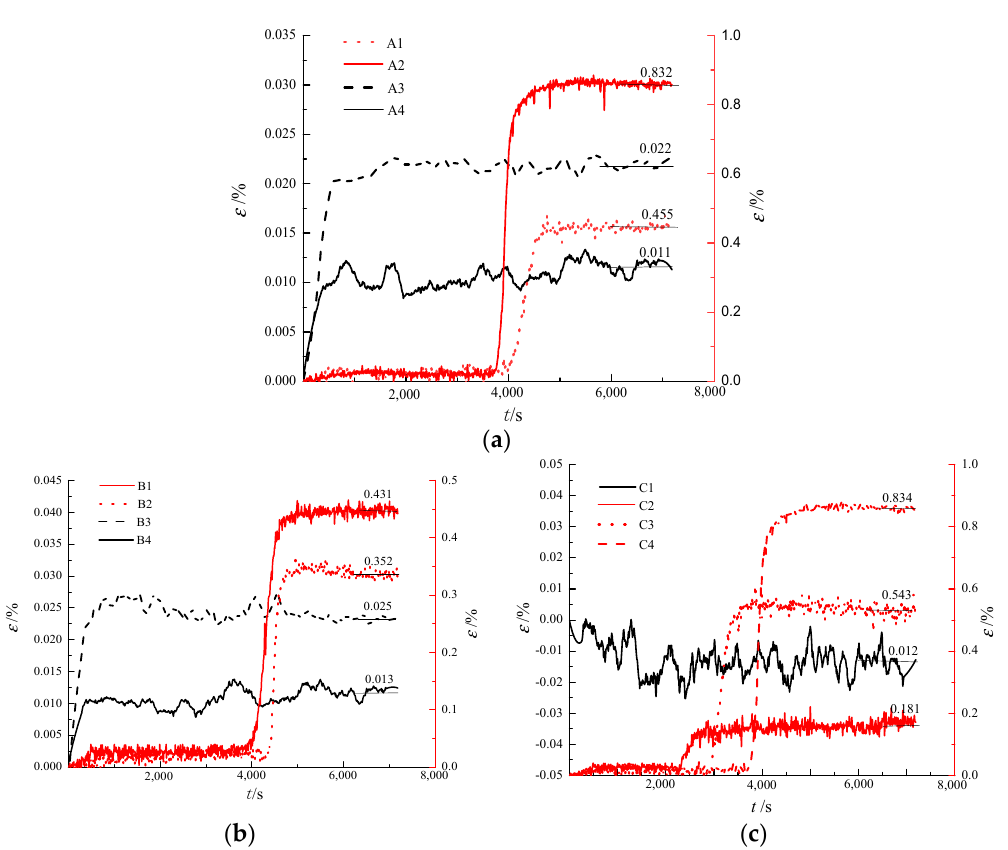
Figure 11. The evolution of generalized strain at the crack tip. ( a ) Different crack widths; ( b ) different external temperatures; ( c ) different initial moisture contents.